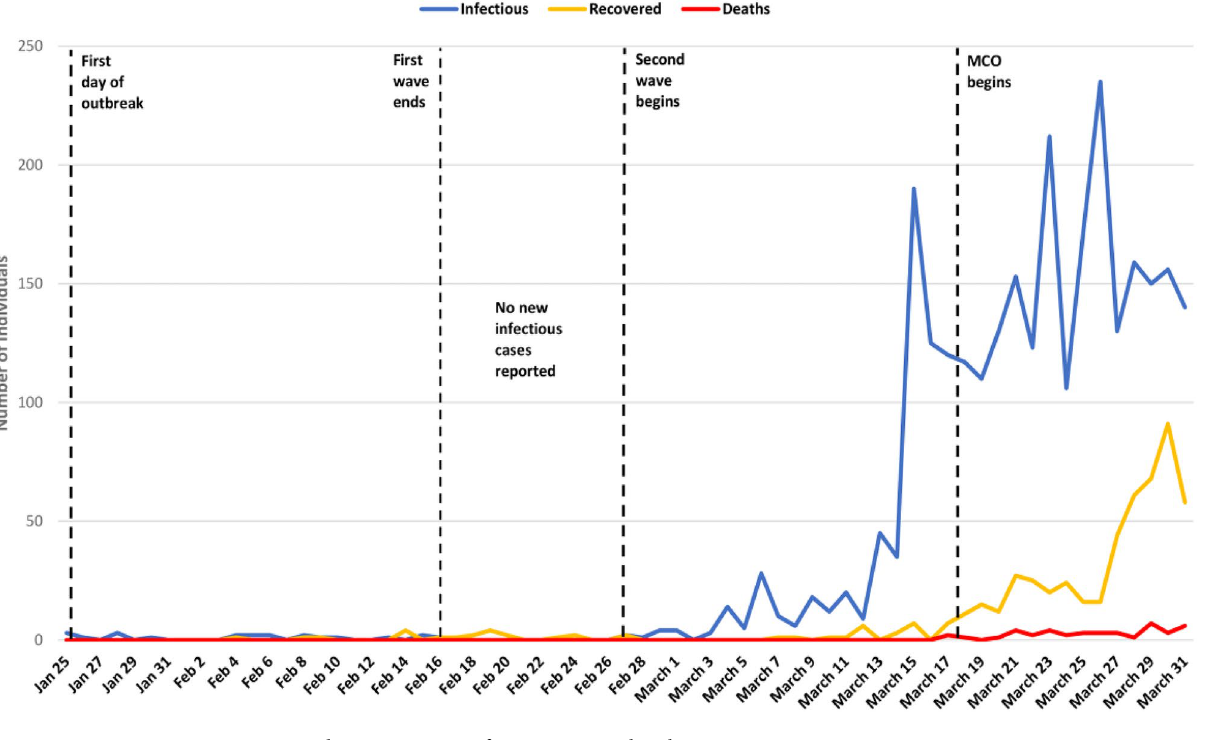
Figure 1. Malaysian scenario of COVID-19